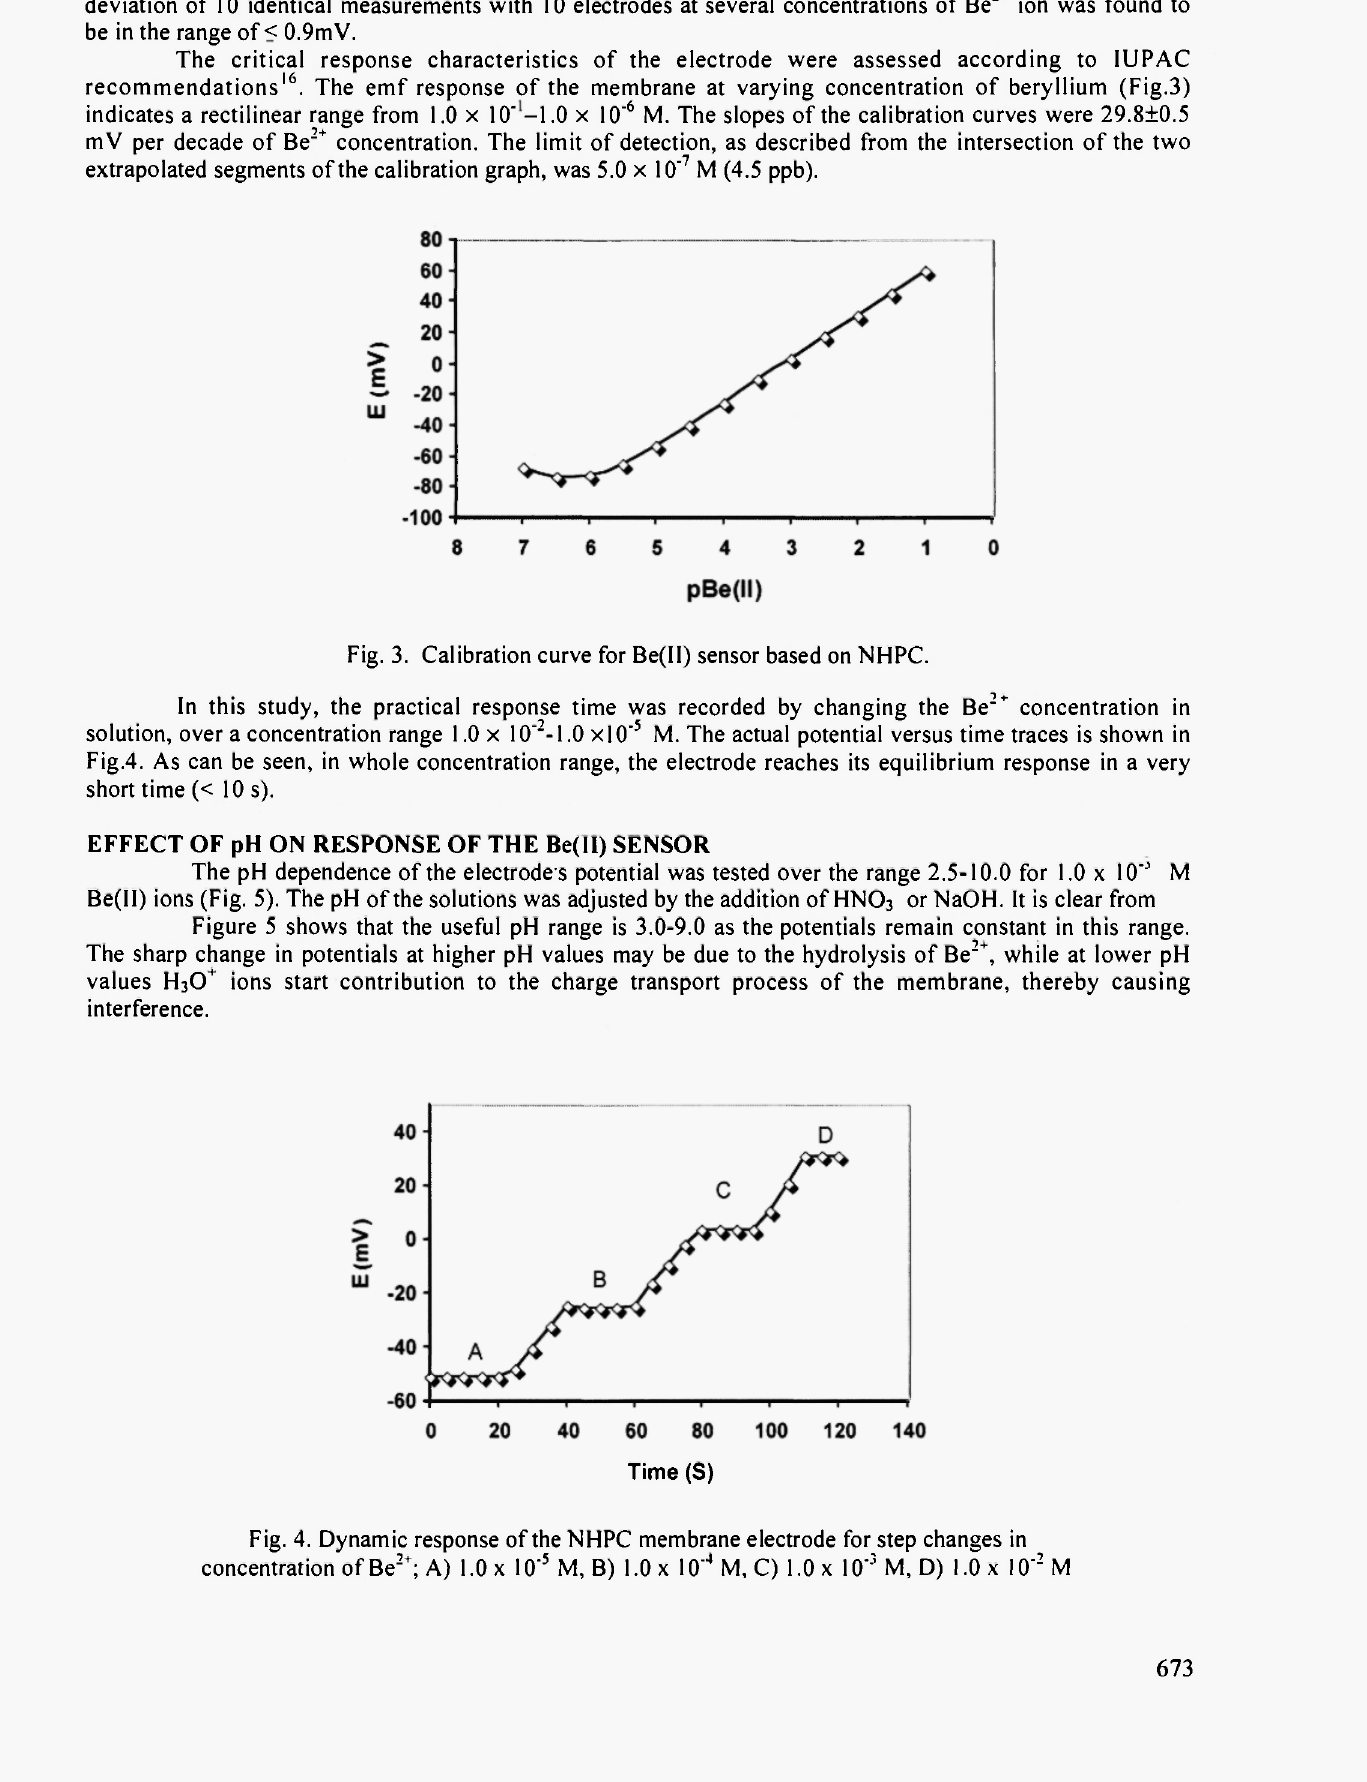
Fig. 4. Dynamic response of the NHPC membrane electrode for step changes